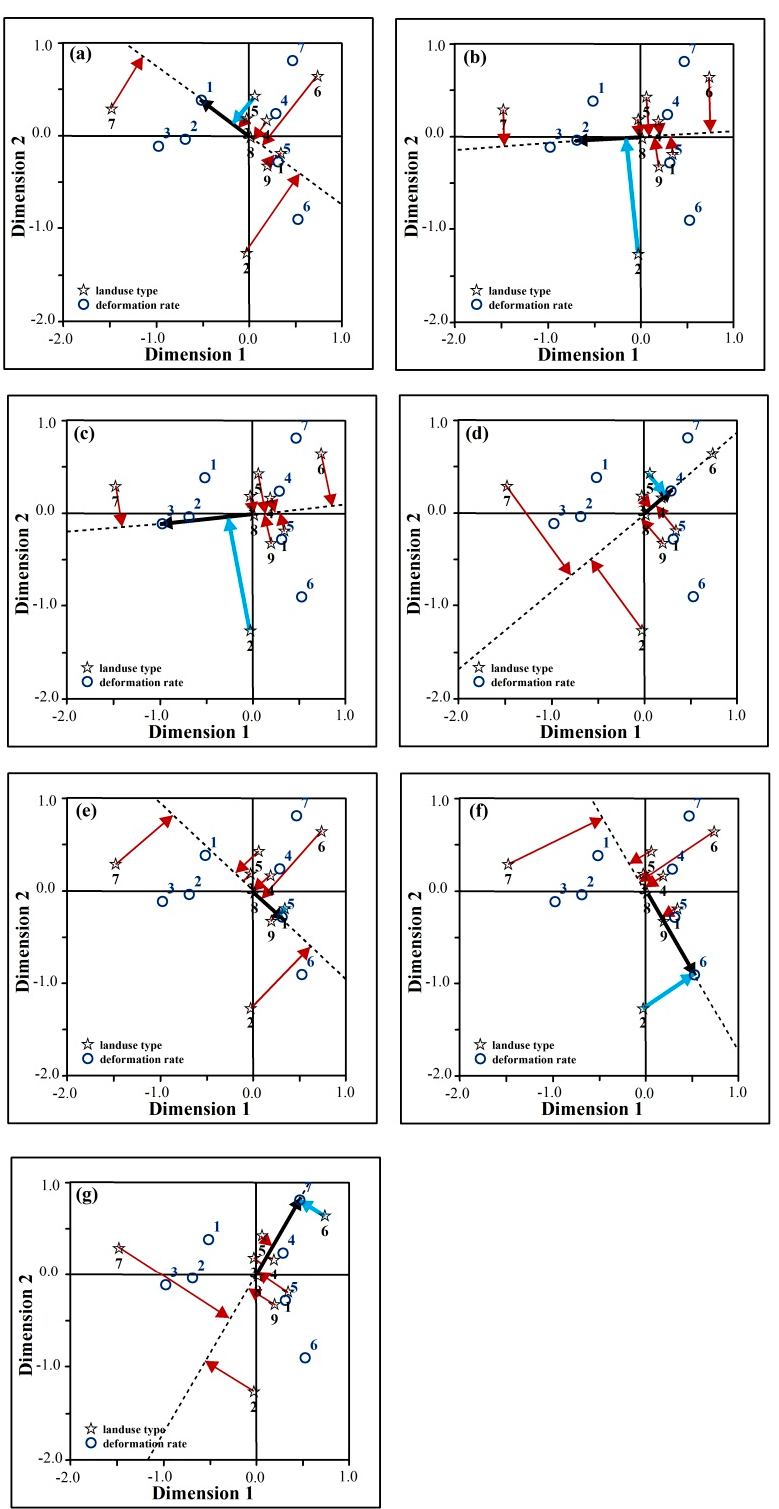
Figure 7. Correspondence analysis chart of land subsidence rate versus the land use types. ( a – g ) The figures of the corrections between nine land use types and seven land subsidence rate classifications. The solid black arrows indicate vectors and the arrows of the direction of the positive vector. The black dotted lines are the extension of the vectors. The red solid arrows indicate perpendicular lines from each land use type to the vectors. The blue solid arrows are the closest to the vectors.